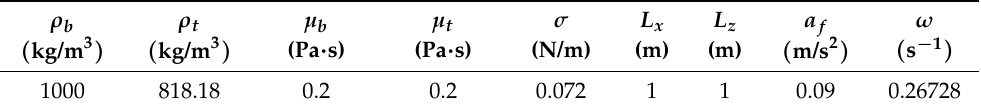
Table 4. Physical parameters defining the nonlinear test case.